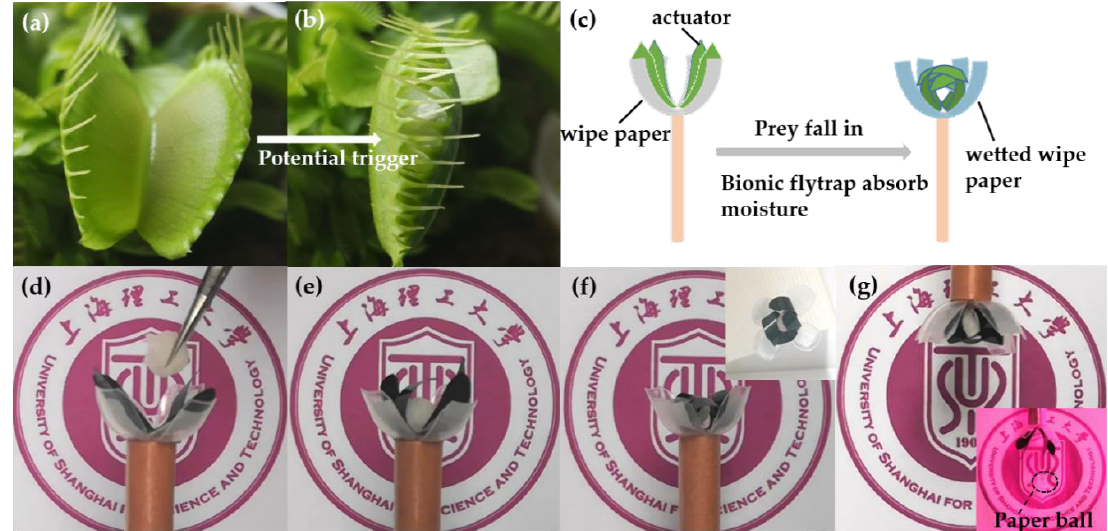
Figure 7. Bionic flytrap. ( a – b ) Schematic diagram of a flytrap in its open and closed state. ( c ) Schematic illustration of the structure and operation principle of bionic flytrap. ( d – f ) The process of bionic flytrap captured a wet paper ball and top view of bionic flytrap. ( g ) Bionic flytrap in inverted place and released “prey” paper ball under high energy infrared light.